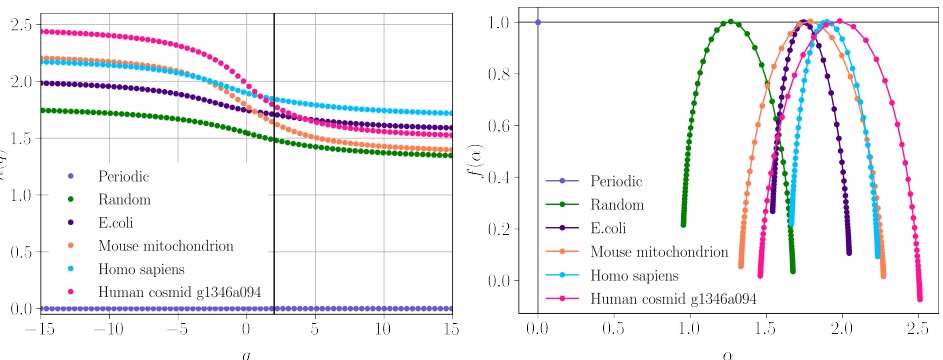
Figure 4. MFDFA analysis of DNA sequences. ( Left ) Generalized Hurst exponents h ( q ) . The vertical line at q = 2 helps to visualize the values h ( 2 ) . They are in very good agreement with those obtained from the variation log F ( n ) vs. log n as shown in Figure 4. ( Right ) f ( α ) spectra, where α are scaling